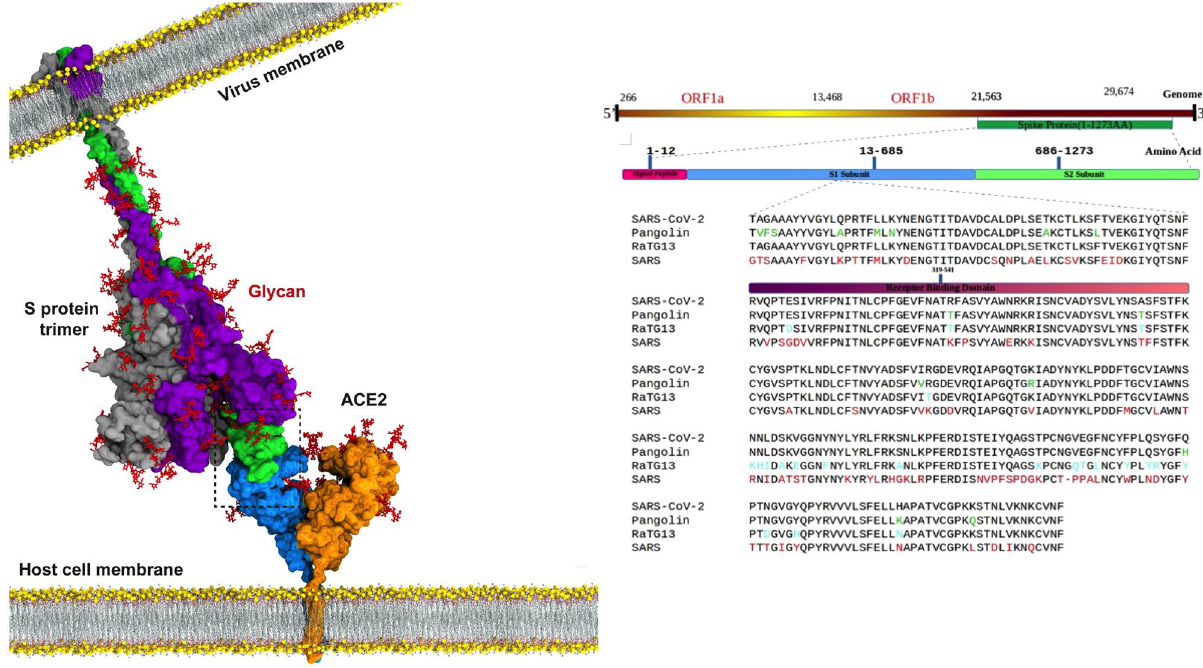
Figure 1. Upper panel: Picture of the complex formed by SARS-CoV-2 S protein and human ACE2 (CC-BY- NC-ND 4.0 International license; adapted from Taka et al. 15 ). Lower panel: Sequence alignment of S1